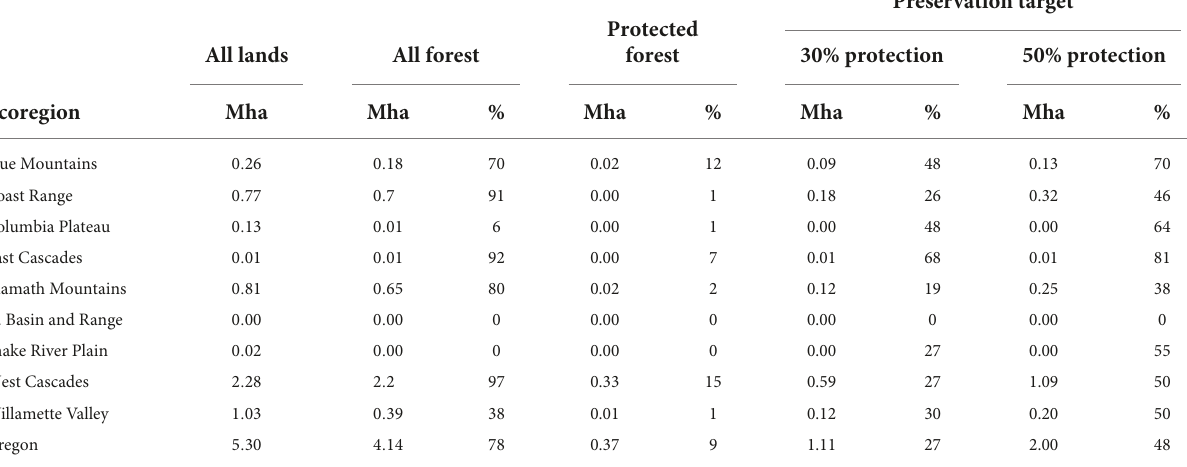
TABLE 5 Surface drinking water source areas for public water systems in each ecoregion’s forests, protected forests, and forests that would be protected by meeting preservation targets using joint